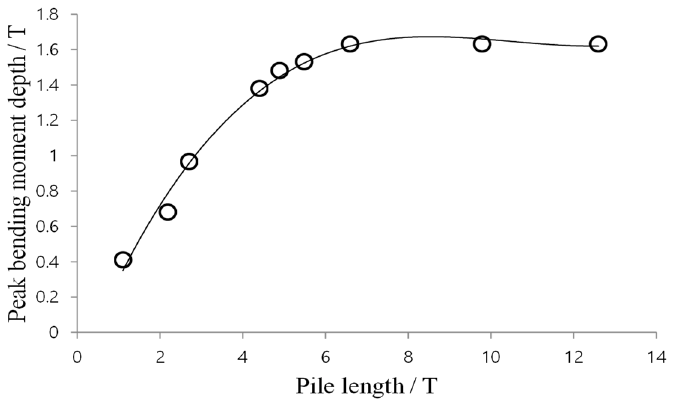
Figure 20. Relationship between pile length and peak bending moment depth.